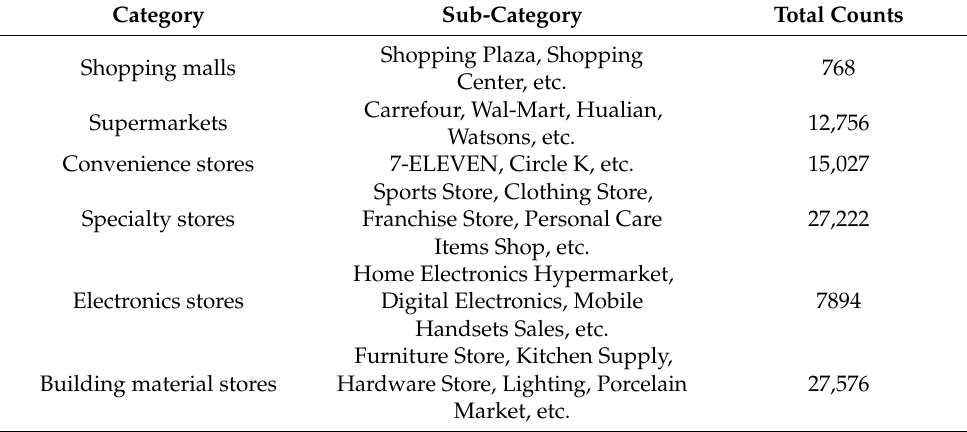
Table 1. Categories and total counts of